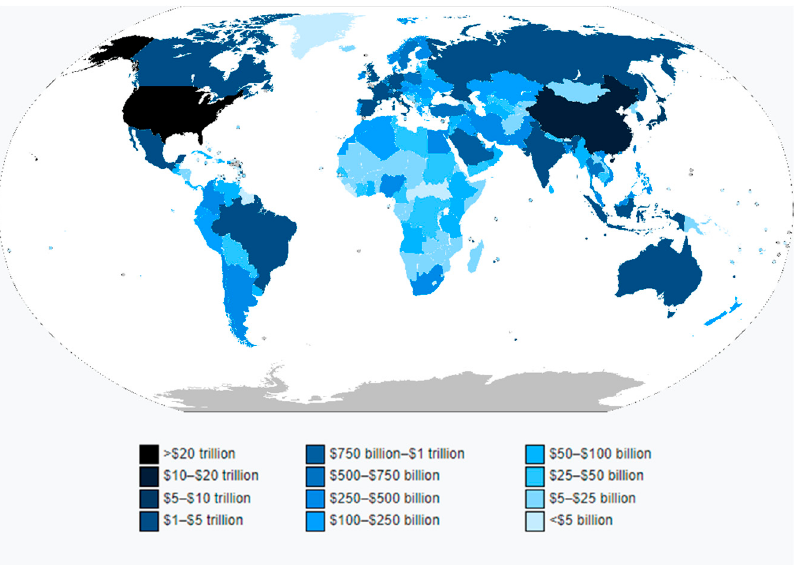
Figure 6. Countries by nominal GDP in 2019. Source: World Economic Outlook Database. Interna- tional Monetary Fund (IMF). Retrieved: 13 October 2020 [50].